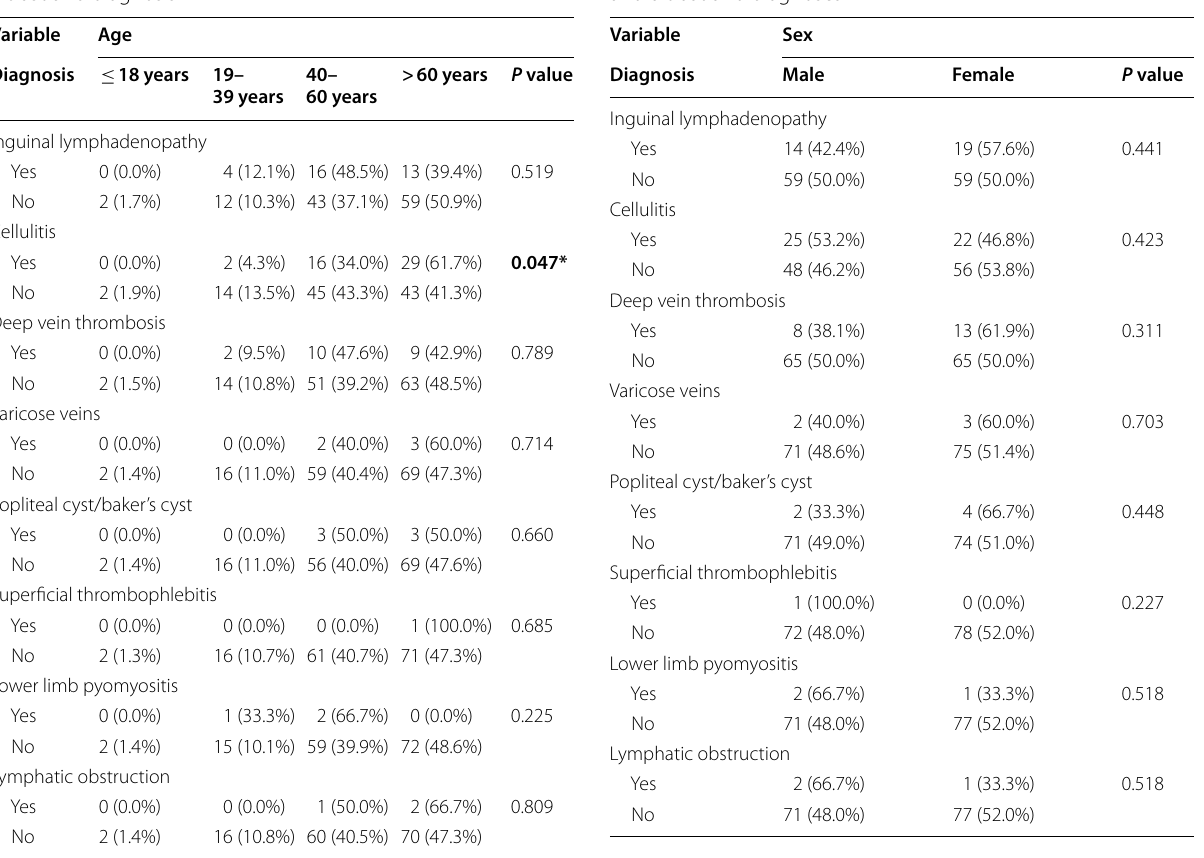
Table 5 Distribution showing the relationship between age and ultrasound diagnosis